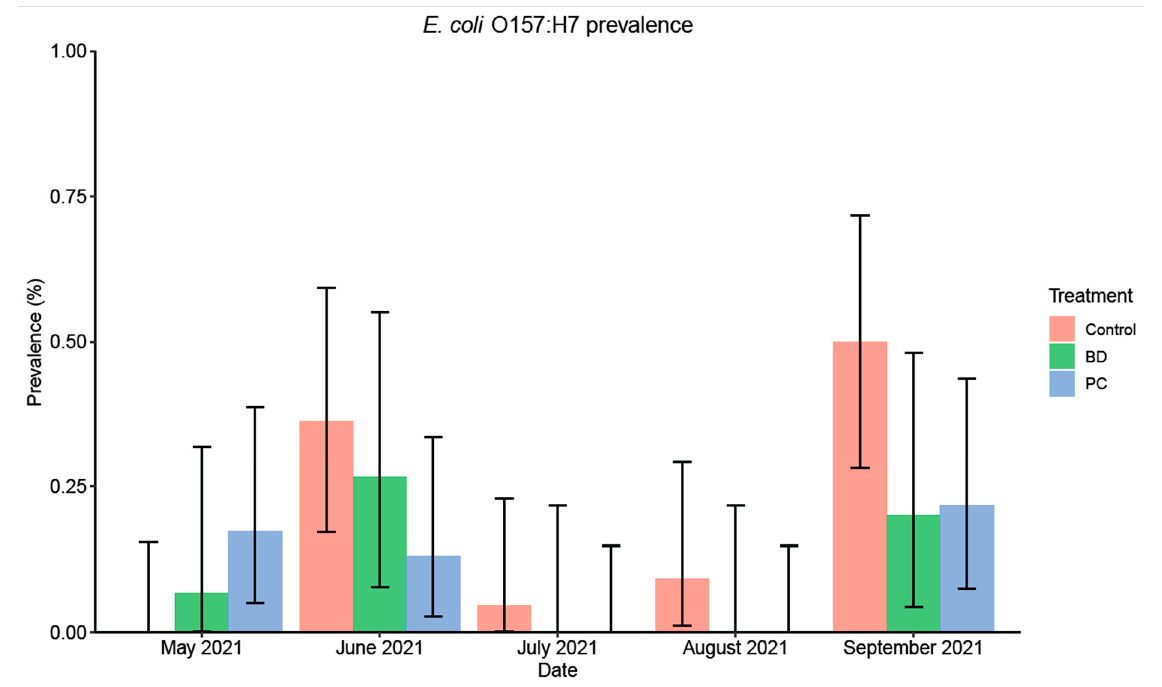
Figure 1. E. coli O157: H7 prevalence (%) of fecal samples collected from the pen floors over the course of a 5-month sampling period at three different feed yards ( n = 3 pens/feed yard). Control (May: 0/22, June: 8/22, July: 1/22, August: 2/22, September: 11/22); BD (May: 1/15, June: 4/15, July: 0/15, August: 0/15, September: 3/15); PC (May: 4/23, June: 3/23, July: 0/23, August: 0/23, September: 5/23). Error bars represent 95% confidence intervals (CI).